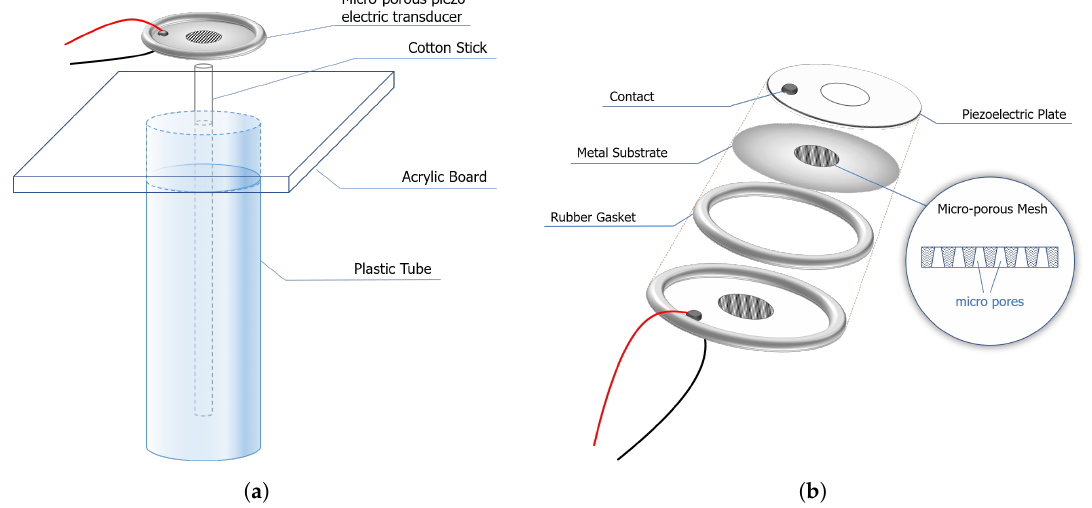
Figure 2. Odor dispenser. ( a ) An atomizer with a micro-porous piezoelectric transducer; and ( b ) a micro-porous piezoelectric transducer.